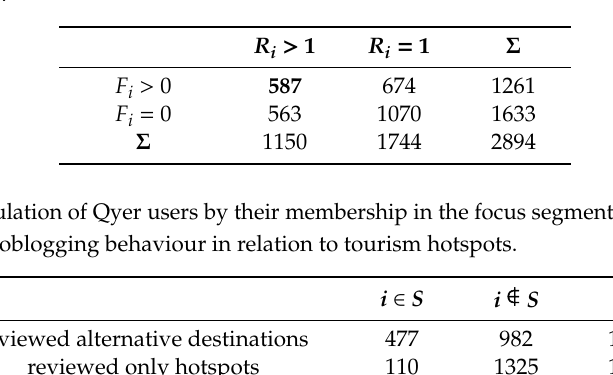
Table 1. Cross-tabulation of Qyer users based on their number of followers F i and their number of reviewed places R i .